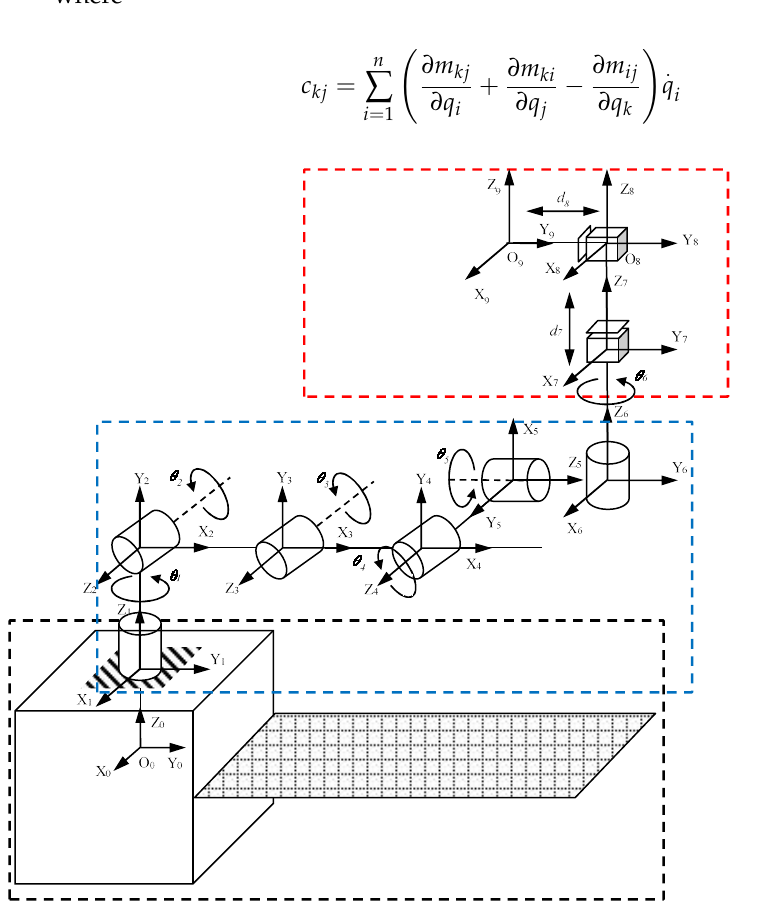
Figure 2. Space detumbling robot modeling.